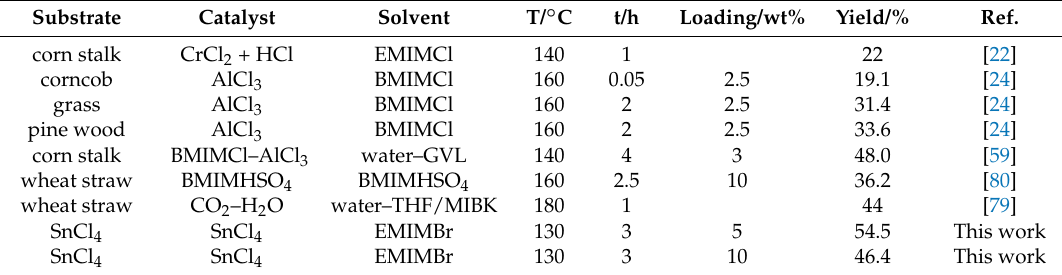
Table 4. Comparisons of catalytic performance of the EMIMBr/SnCl 4 system with representative catalytic systems for conversion of lignocellulosic biomass to